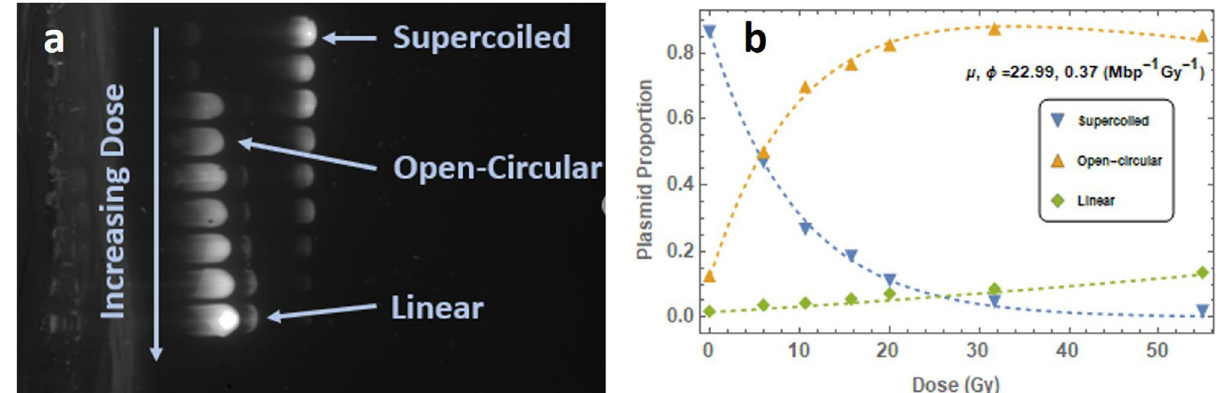
Figure 8. ( a ) Cropped UV image of agarose gel following electrophoresis containing wet plasmids irradiated by 100 MeV electrons. Labelled bands indicate presence of SC, OC and L plasmid forms. Uncropped image shown in SF5. ( b ) SC, OC and L plasmid proportions as a function of dose following integration of band intensities, fitted to Eqs. (2), (3) and (4). Error bars calculated based on five gel